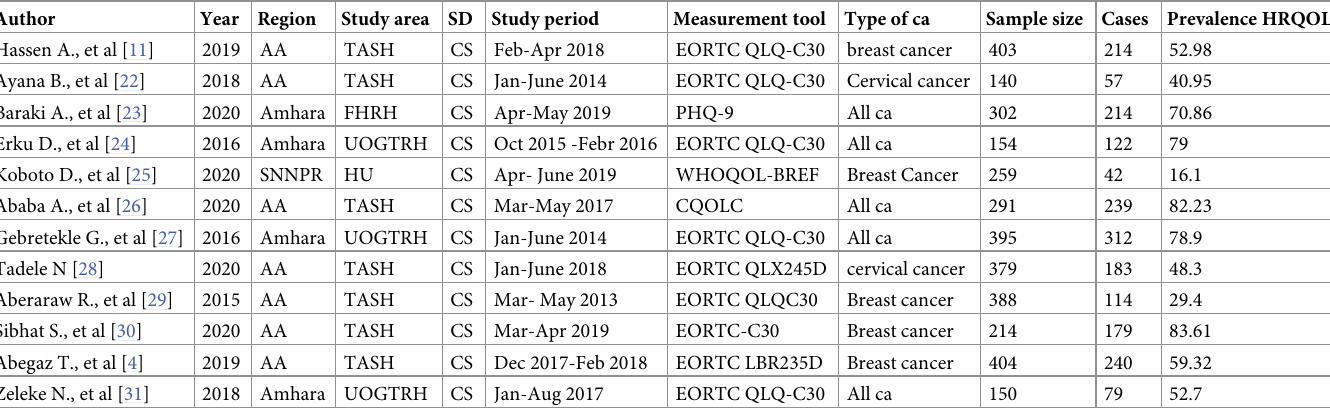
Table 2. Characteristics of studies included in a systematic review on the prevalence of health-related quality of life among cancer patients in Ethiopia,